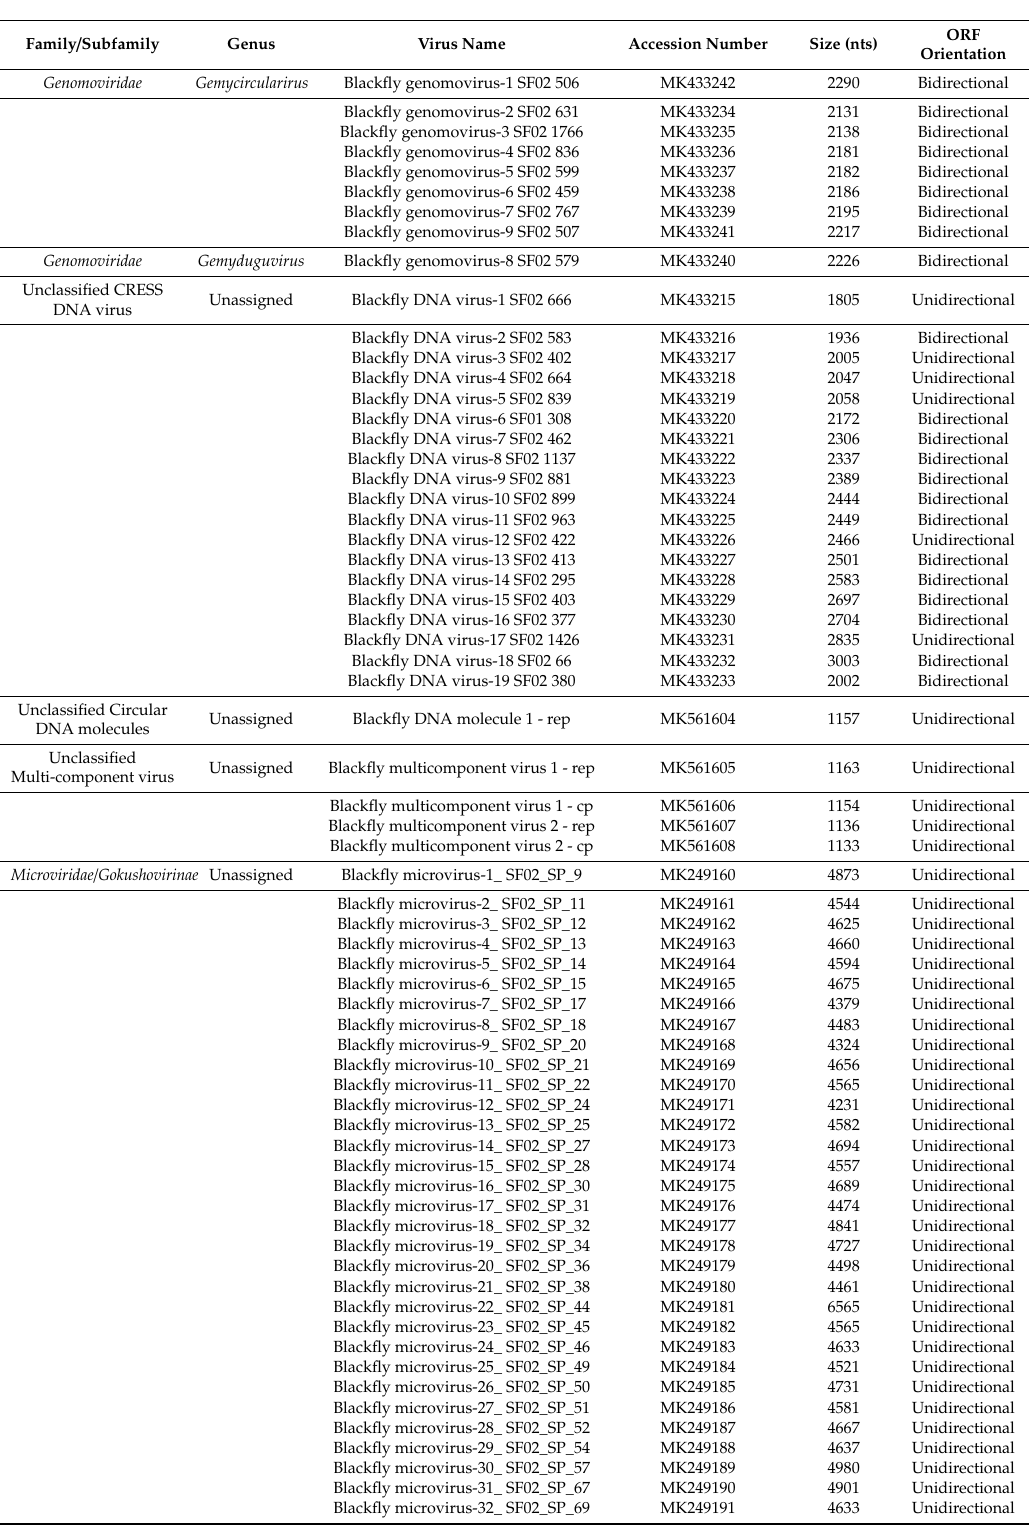
Table 1. Summary of the genomes of blackfly associated viruses including genome organisation and GenBank Accession